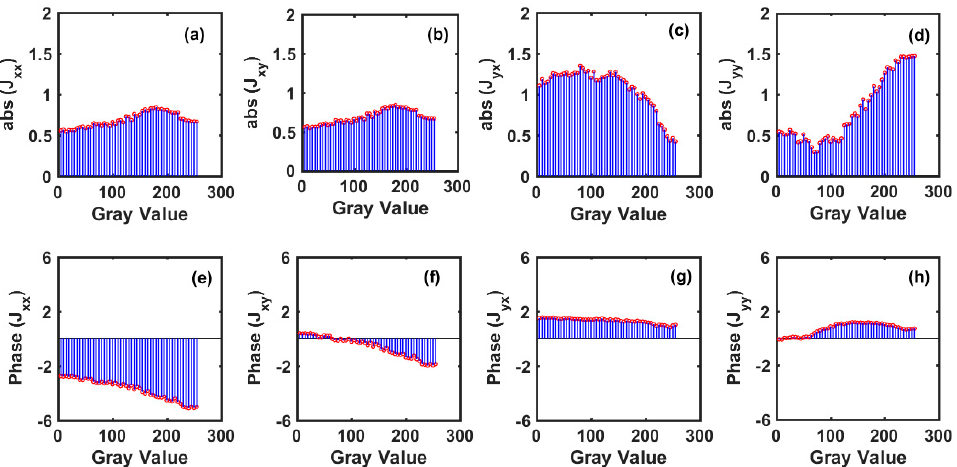
Figure 7. Jones matrix components as a function of grayscales of the SLM. ( a – d ) Amplitude and ( e – h ) phase of Jones matrix components. Amplitude is represented in arbitrary units and phase is represented in radians.